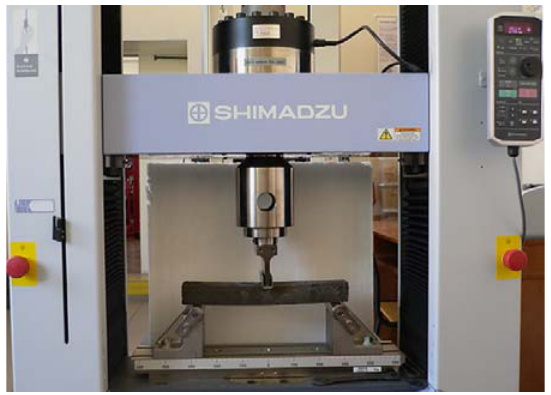
Figure 5. Bending test of the sample.